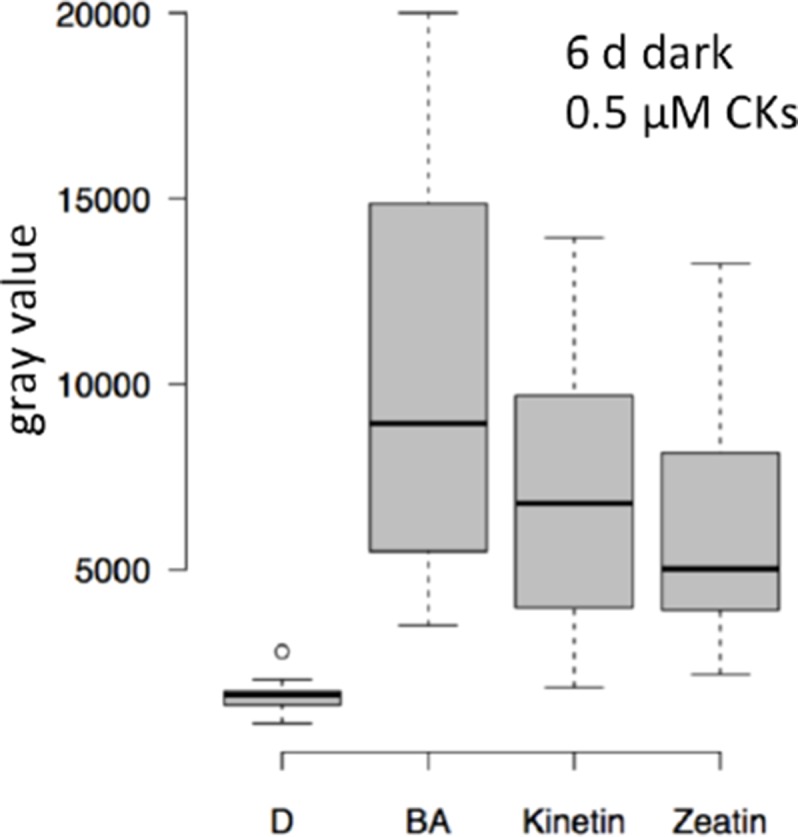
DOI:
http://dx.doi.org/10.7554/eLife.17023.018